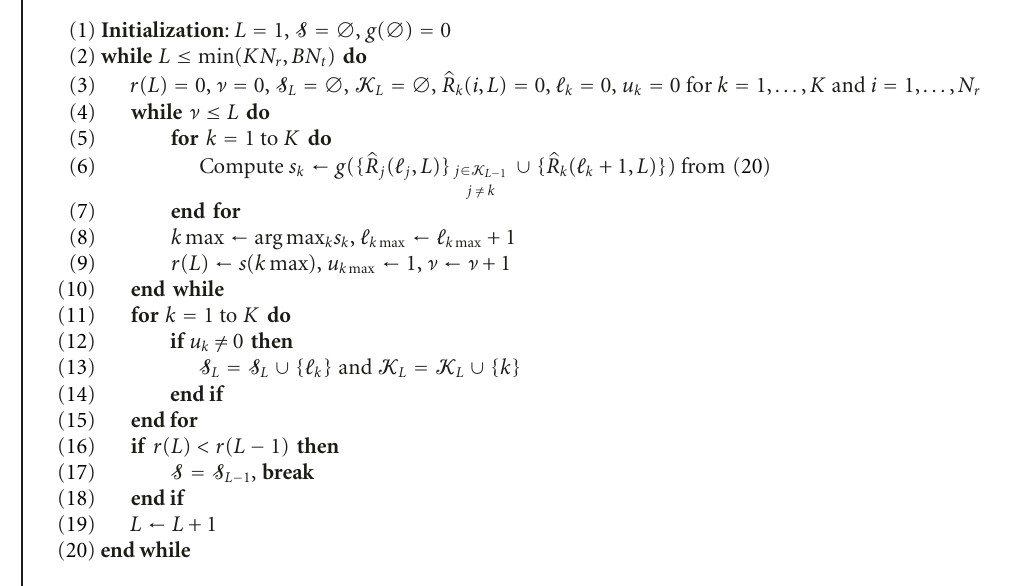
Algorithm 1: Pseudocode for the proposed algorithm.